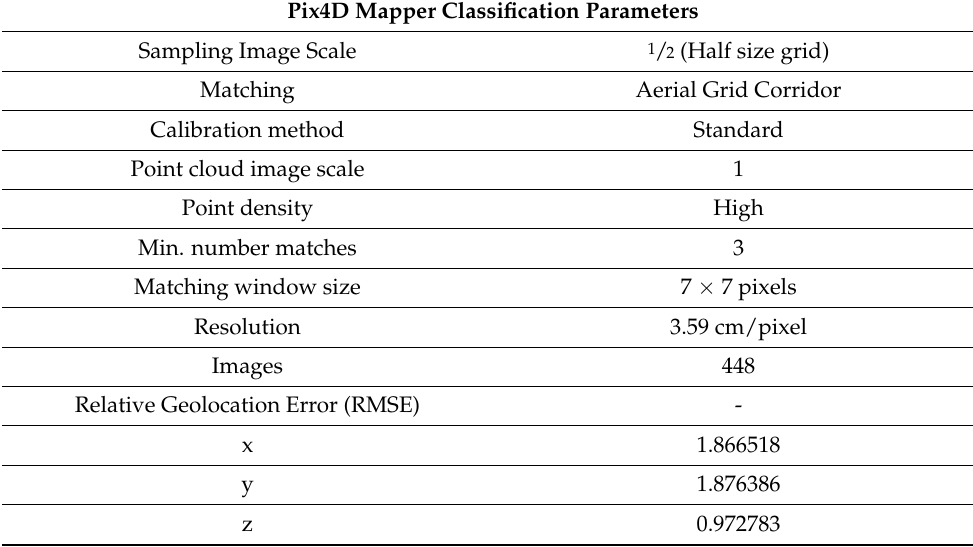
Figure 1. Dark-colored red spruce caps the summit of Whitetop Mountain. Note the presence of standing dead spruce within the stand. A communications tower is visible in the center and a small spruce reforestation project in the lower right extends down into the grass bald. Spruce- covered Mount Rogers, Virginia’s tallest mountain, is visible in the background. Viewing direction is approximately ENE, UAV-generated image (4 April 2020). Table 1. Classification parameters were set within photogrammetric software Pix4D to generate high-quality geospatial products, including digital orthoimagery, for the Whitetop sample